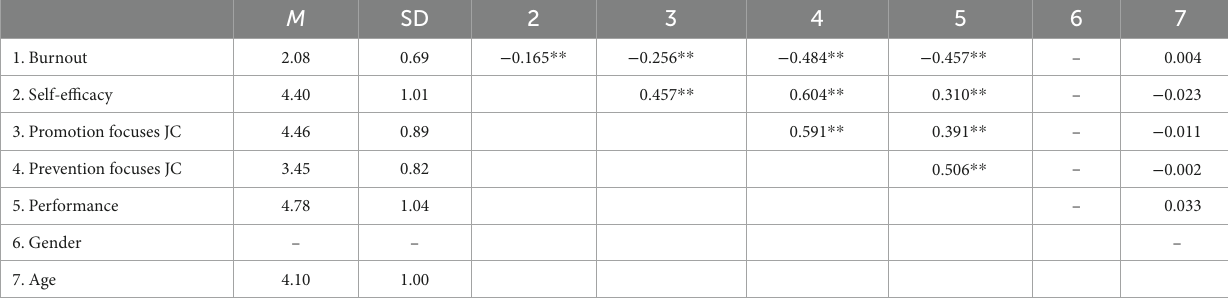
TABLE 1 The means, standard deviations, and correlations between variables.